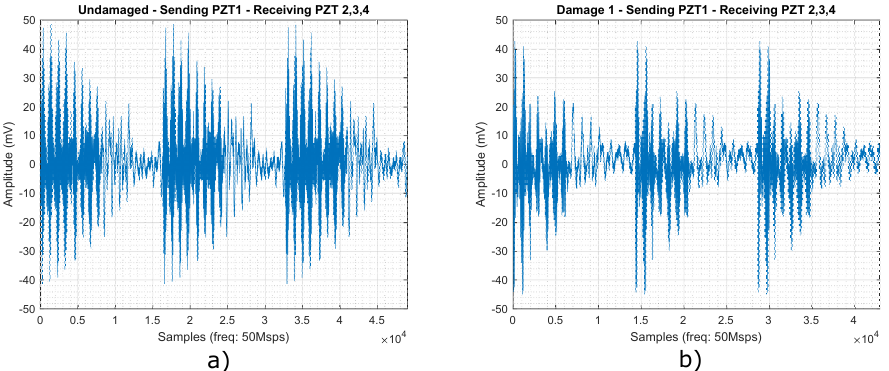
Figure 5. Received signals for actuation Phase 1 when: ( a ) there is no damage in plate and ( b ) Damage 1 is performed on the